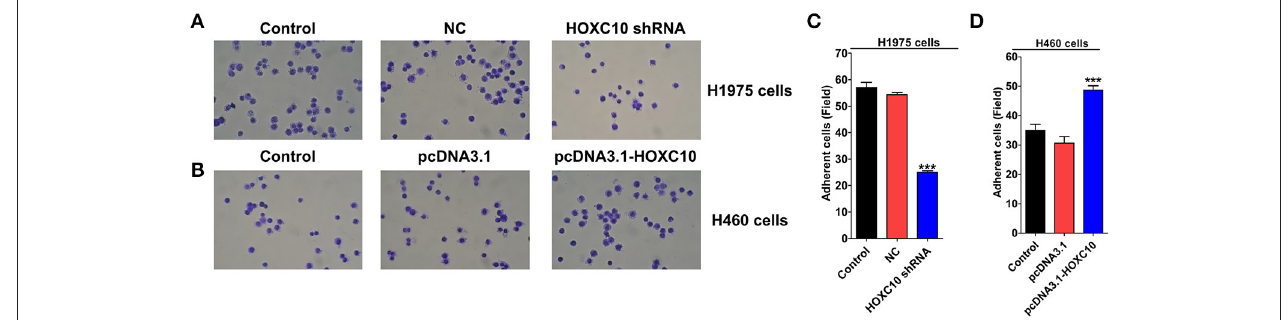
FIGURE 4 | HOXC10 inhibits cell adhesion in vitro . H1975 cells and H460 cells were transfected with indicated shRNA or plasmid, respectively. Tumor cell adhesion assay was performed as described in materials and methods. Three random fields of H1975 cells (A,C) and H460 cells (B,D) were photographed, and the cells in each field were calculated. Magnification, × 200. Control, untreated cells; NC, scramble shRNA control. Data are presented as means ± SD , n = 3, *** p < 0.0001 vs. control